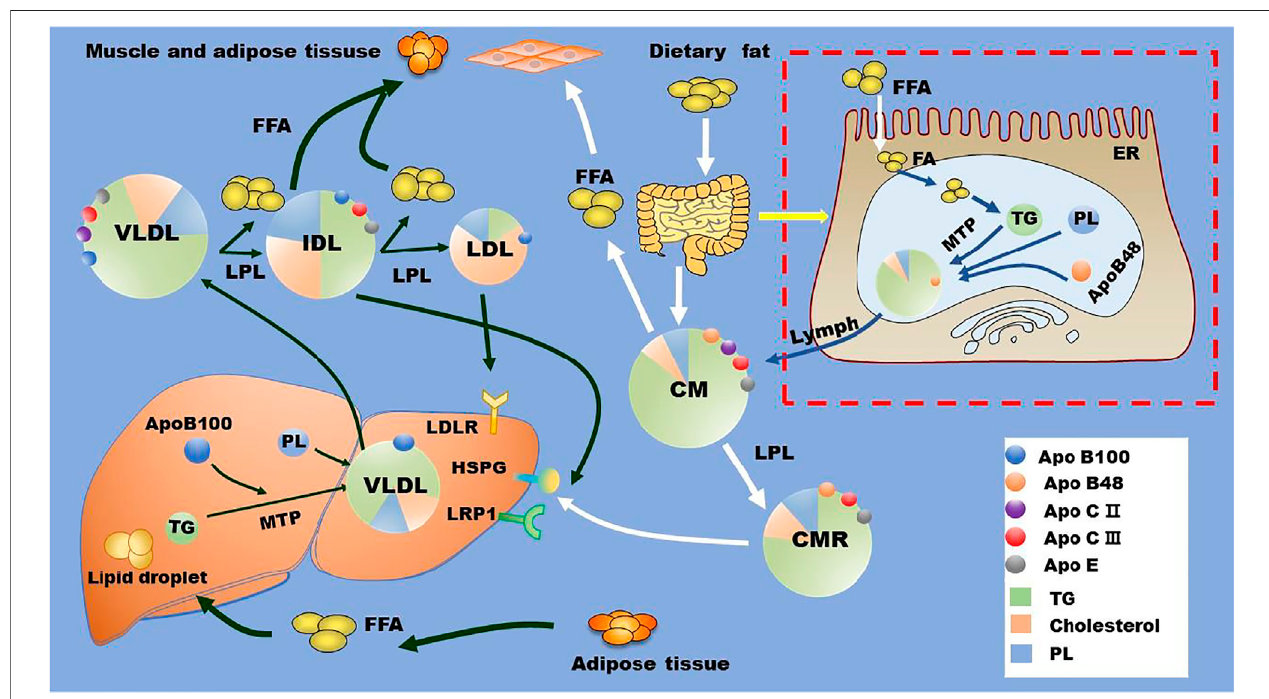
FIGURE1| TGandTGRLmetabolism.DietaryfatismetabolizedbyintestinalcellsintoFAs,whicharereassembledwithcholesterol,phospholipids,andapoB48to form CMs. These CMs are released into blood via lymph. In the liver, exogenous and de novo synthesized FAs are assembled with cholesterol, phospholipids, and apoB100 to form VLDL with the assistant of MTP. In the circulation, LPL located at the surface of the capillary lumen hydrolyzes the TG in the core of TGRL (CM and VLDL) and promotes the production of TGRL remnants and free FAs. TGRL remnants are cleared by liver through receptors including HSPG, LDLR, LRP1, and other potentially unidenti fi ed receptors. Apo, apolipoprotein; CM, chylomicron; CMR, chylomicron residual; ER, endoplasmic reticulum; FA, fatty acid; FFA, free fatty acid; HSPG, heparan sulfate proteoglycan; IDL, intermediate density lipoprotein; LDL, low-density lipoprotein; LDLR, low-density lipoprotein receptor; LPL, lipoprotein lipase; LRP1, LDLR-related protein 1; MTP, microsomal triglyceride transfer protein; PL, phospholipids; TG, triglycerides; VLDL, very low-density